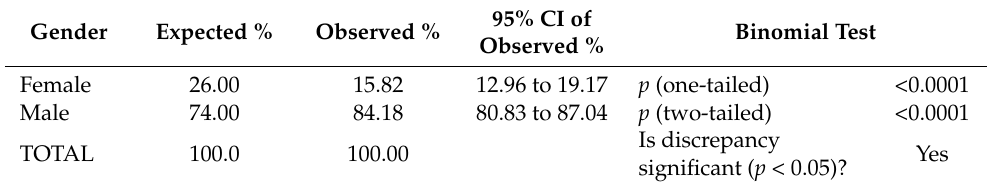
Figure 2. Graphical representation of the comparison of the composition of the combined data of national and local dental boards with that of the population practicing dentistry in Italy, represented, in terms of percentages, as 74% male and 26% female. Table 3. Binomial test for the comparison of the composition of the combined data of national and local dental boards with that of the population practicing dentistry in Italy. The discrepancy resulted as statistically significant.